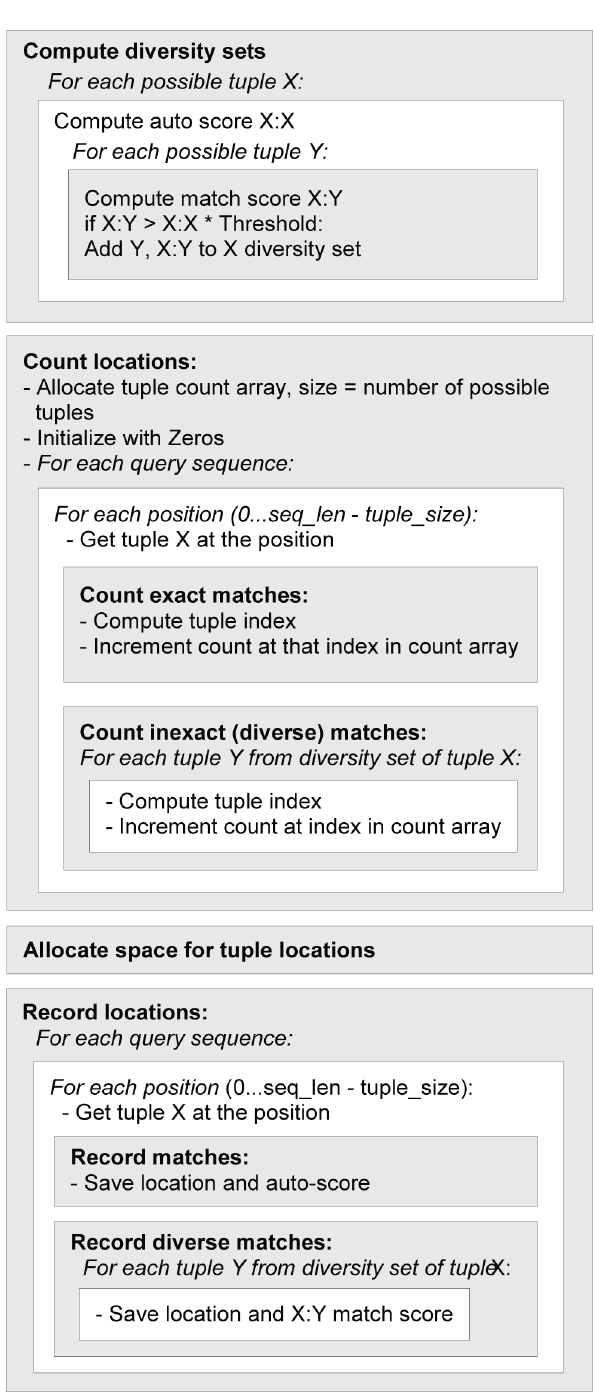
Figure 2. Block-scheme for dictionary construction. Location of every character tuple of the size K in the query sequences is recorded in a directly addressable Lookup Table, where a binary-converted tuple by itself serves as an index. Each entry in the table is a pointer to an array of locations.